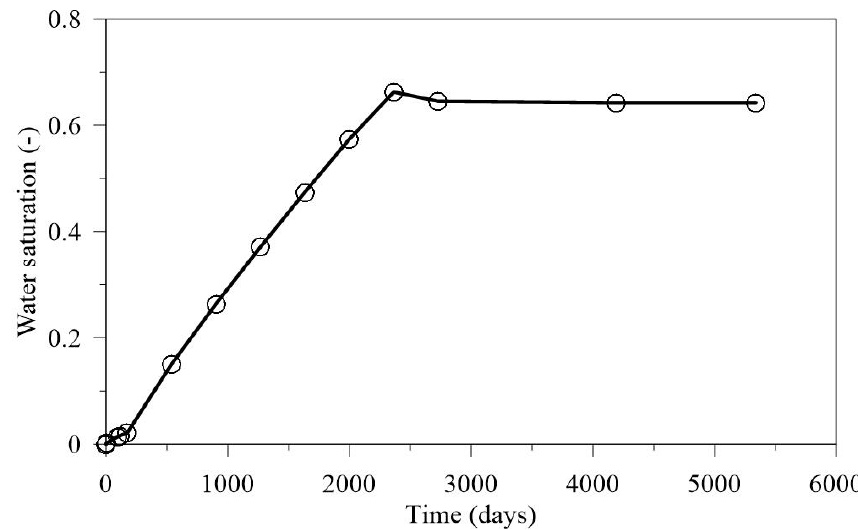
Figure 13. Water saturation evolution at the ALC1604 cell.